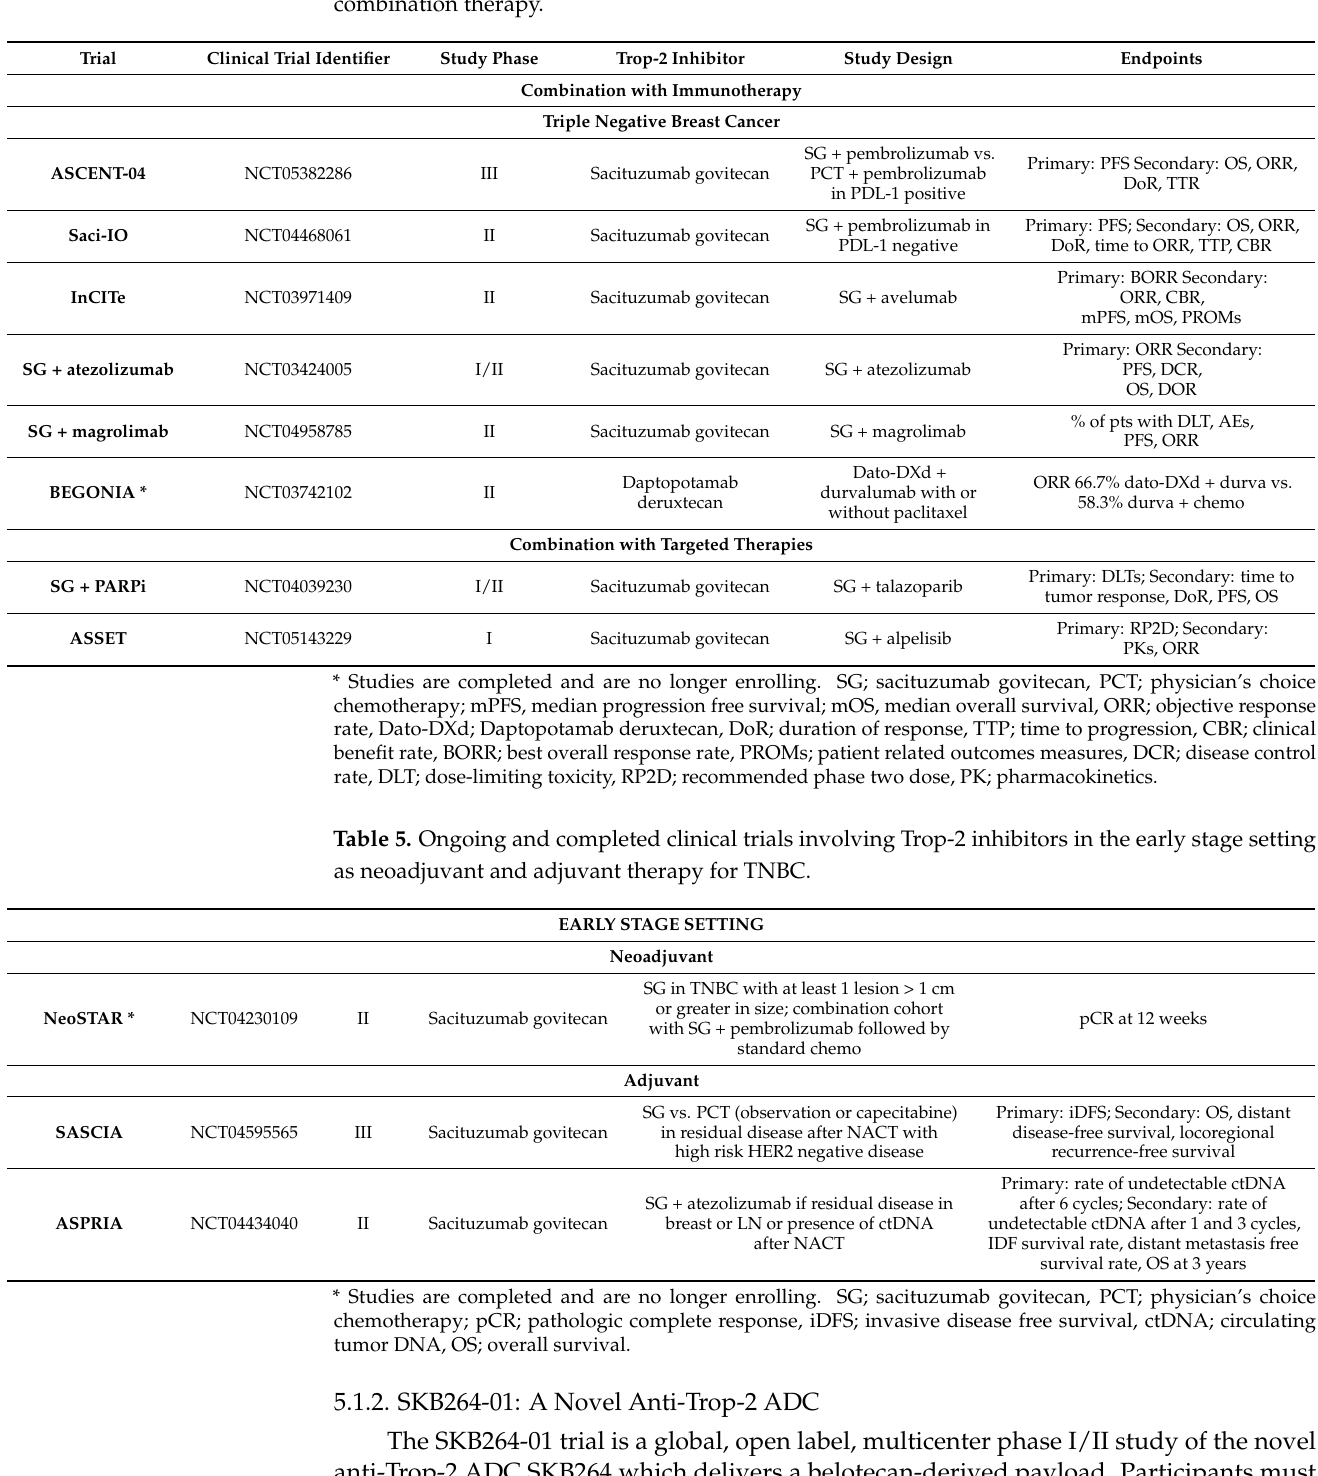
Table 4. Ongoing and completed clinical trials involving Trop-2 inhibitors in metastatic TNBC as combination therapy.